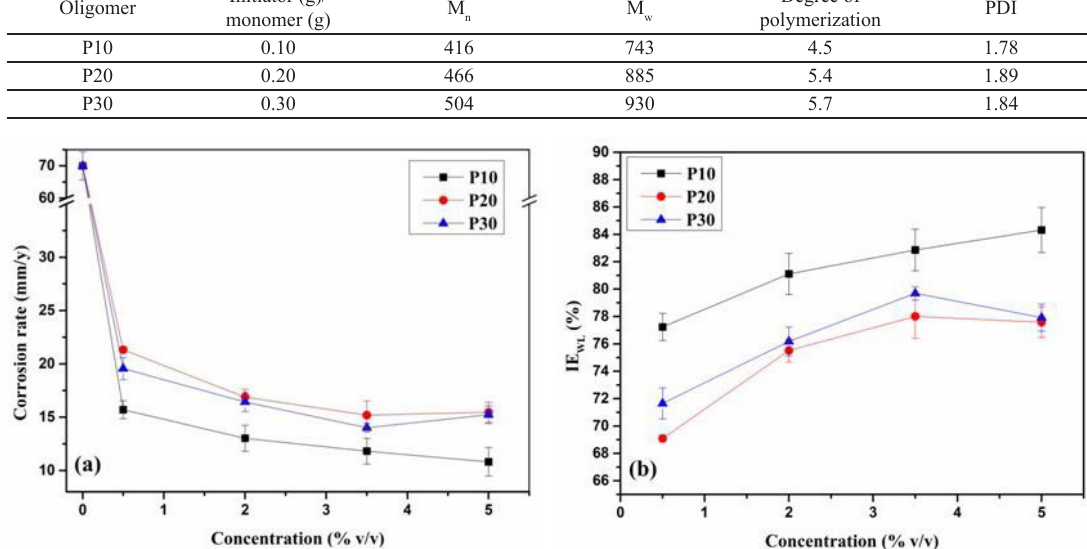
Table 1. Size exclusion chromatography results obtained for oligomers P10, P20 and P30: Mn, Mw, degree of polymerization and PDI.